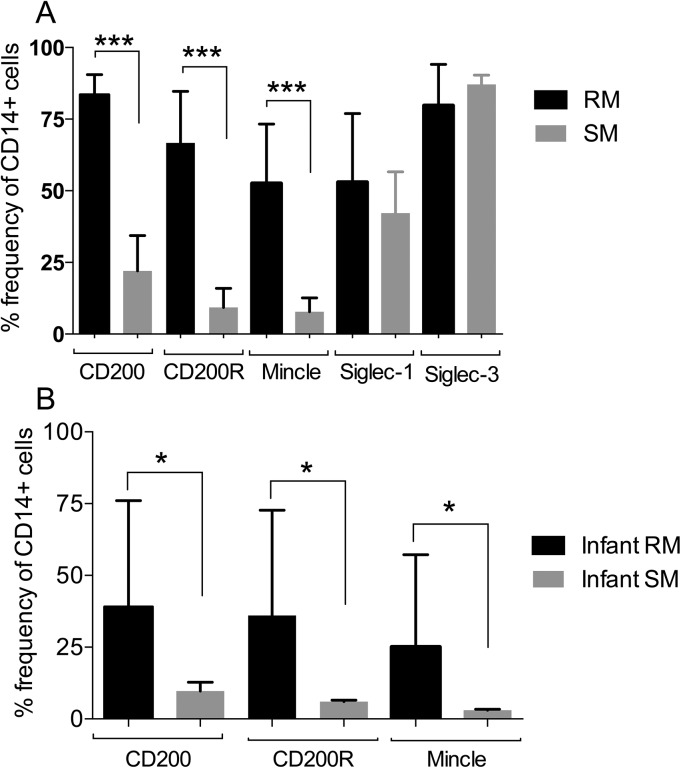
Comparative analysis of the frequencies of CD200, CD200R, Mincle, Siglec-1 and Siglec-3 expressing cells by the gated population of CD14+ cells from the PBMC samples from normal adult rhesus macaques (n = 19, black bars) and sooty mangabeys (n = 18, grey bars) (A) and similar analysis on infant (< 3 months) rhesus macaques (n = 10) and sooty mangabeys (n = 4) (B).The notations * represents p < 0.05 and *** represents p < 0.001.